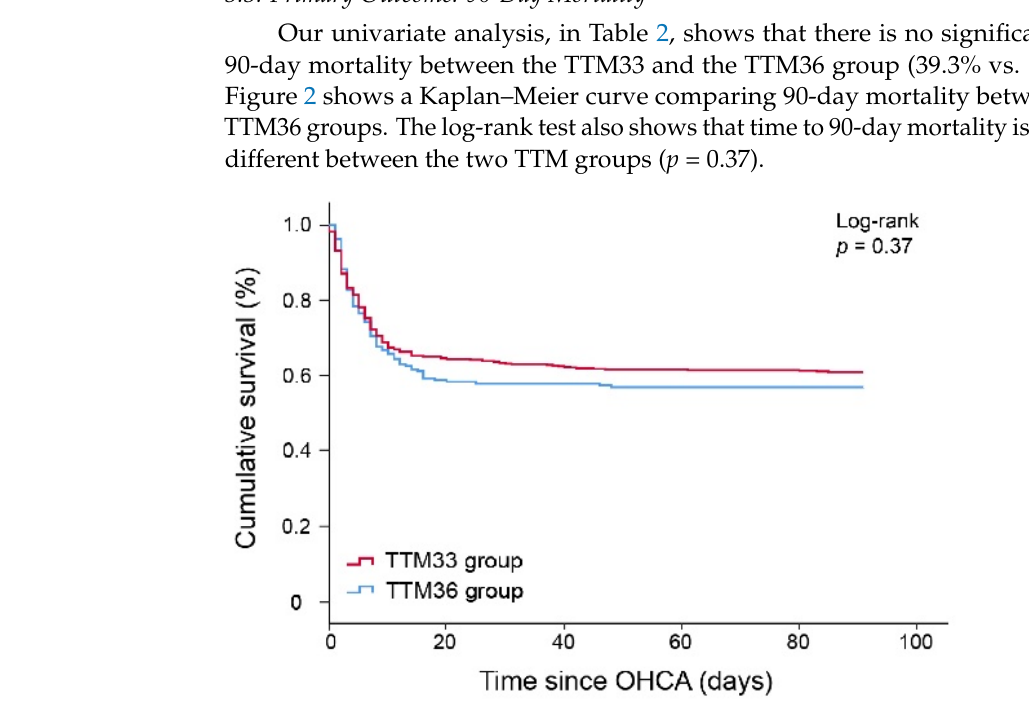
Figure 2. Kaplan–Meier curve 90-day mortality.